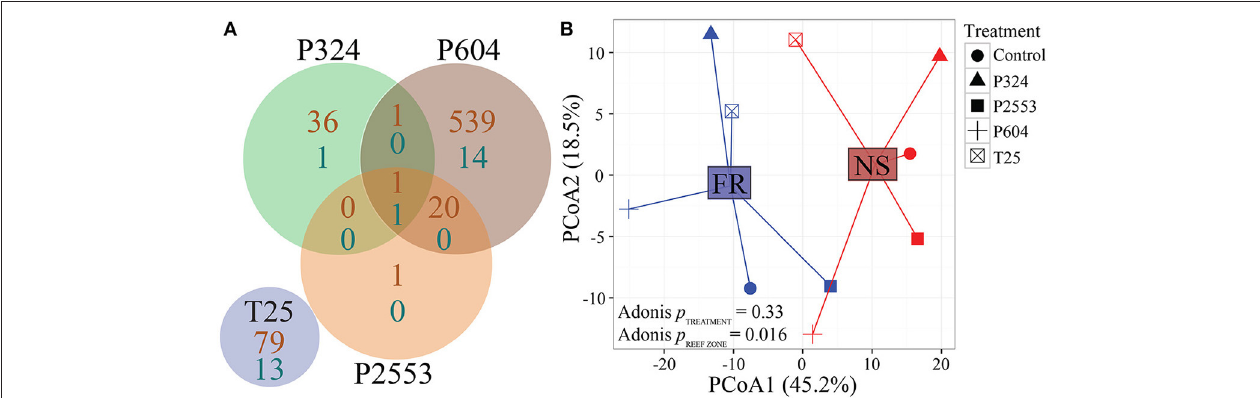
FIGURE 3 | Global RNAseq patterns for in hospite Symbiodinium goreaui under different p CO 2 (28 ◦ C) and low temperature (25 ◦ C) treatments. (A) Venn diagram of the number of differentially expressed S. goreaui genes (out of 45,947, FDR = 0.05) in experimental conditions relative to control conditions. Orange numbers indicate overrepresented genes and turquoise numbers indicate underrepresented genes, but overall very little transcriptomic response is observed. (B) Principal coordinate analysis of all r-log transformed isogroups clustered by experimental treatment and reef zone, demonstrating significantly different transcriptome profiles across S. goreaui from different locations, regardless of experimental treatment (NS = nearshore and FR = forereef; T25 = 25.01 ± 0.14 ◦ C, 515 ± 92 µ atm; Control = 28.16 ± 0.24 ◦ C, 477 ± 83 µ atm; P324 = 28.14 ± 0.27 ◦ C, 324 ± 89 µ atm; P604 = 28.04 ± 0.28 ◦ C, 604 ± 107 µ atm; P2553 = 27.93 ± 0.19 ◦ C, 2553 ± 506 µ atm).